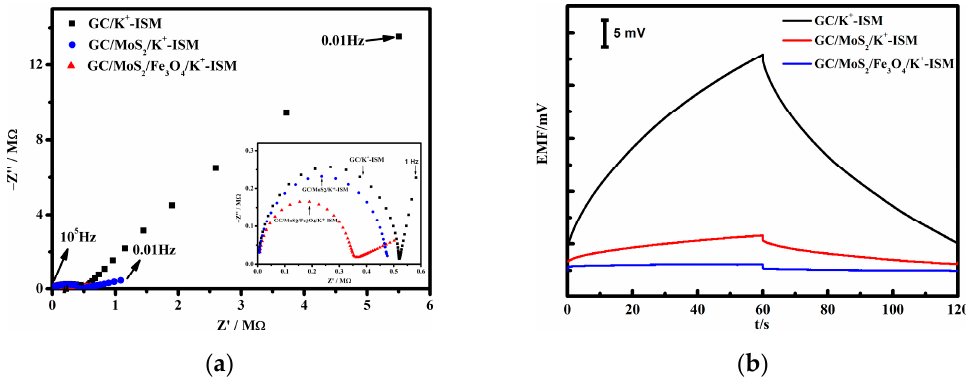
Figure 3. ( a ) Impedance spectra (inset: impedance spectrum in the high-frequency region); ( b ) current reversal chronopo- tentiometry test of GC/K + -ISE, GC/MoS 2 /K + -ISE, and GC/MoS 2 /Fe 3 O 4 /K + -ISE in 0.1 M KCl.